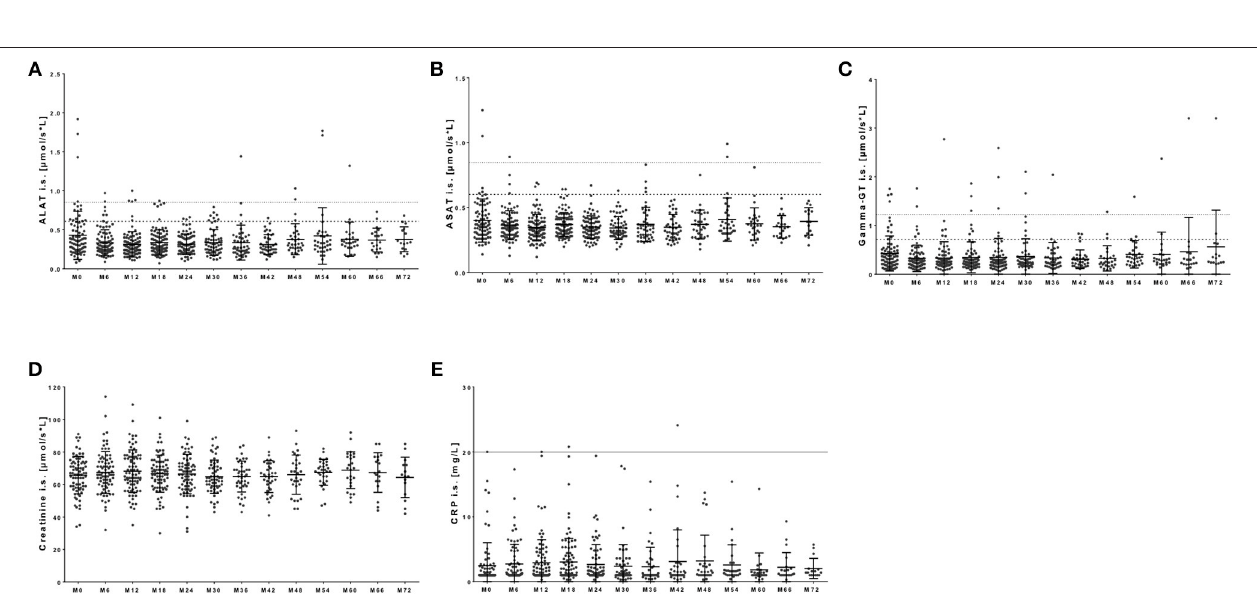
FIGURE 7 | Serological parameters during NAT treatment. Before each infusion started, blood samples were taken and analyzed in a certified medical laboratory. Analysis of serological parameters including ALAT (A) , ASAT (B) , gamma-GT (C) , creatinine (D), and CRP (E) were included. Data are shown for baseline analysis (M0) and sixth months follow up (M6, M12, […], M72). Data are presented as mean ± standard deviation. Dotted line indicates the reverence range for men for ALAT and ASAT at a value of 0.85 µ mol/s*L and for gamma-GT at 1.2 µ mol/s*L. Broken line indicates reverence range for women for ALAT and ASAT at a value of 0.6 µ mol/s*L and for gamma-GT at 0.7 µ mol/s*L. There were no statistical significant changes.